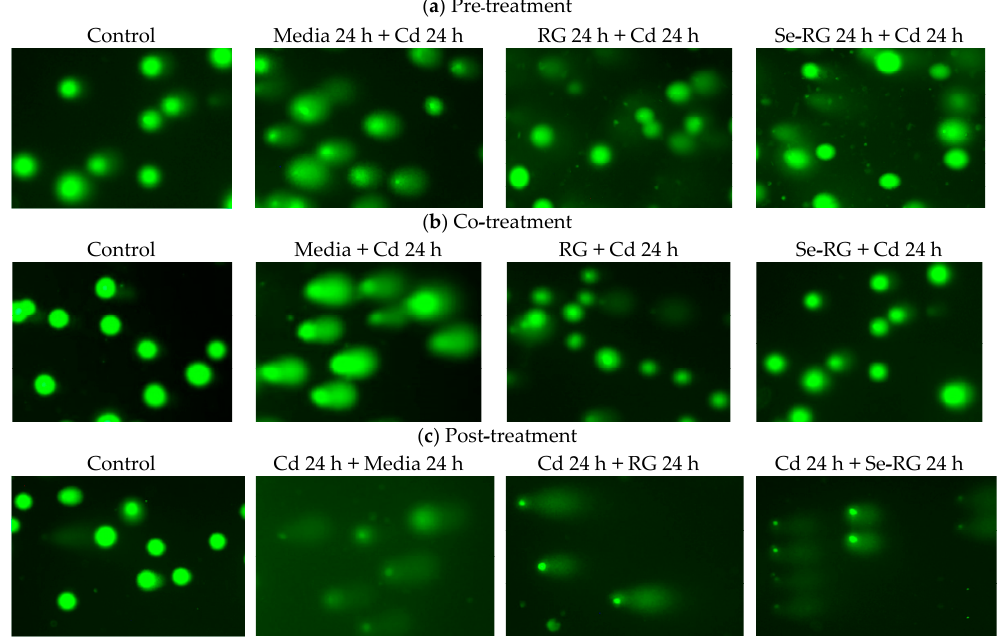
Figure 6. DNA protective effect of RG and Se-RG against CdCl 2 induced DNA break in HEK293 kidney cells while incubated the cells with RG/Se-RG and CdCl 2 at different time order of treating the extracts evaluated by comet assay ( a ) pre-incubation ( b ) co-incubation and ( c ) post-incubation. C means blank control; Cd means CdCl 2 at CC 50 level (68.50 µg/mL).